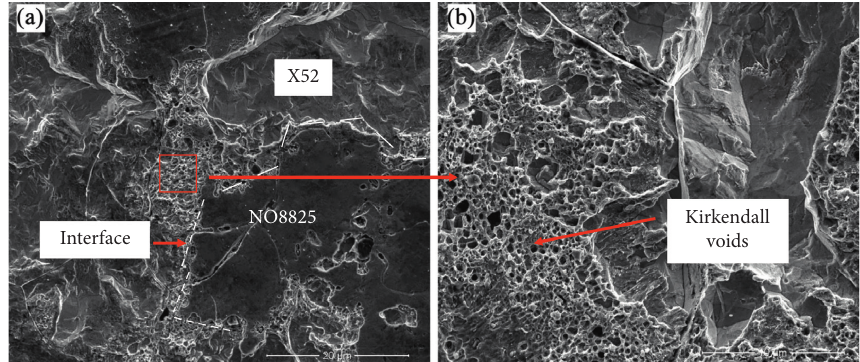
Figure 4: Morphologies of the fresh revealed peeling surface on the carbon steel side: (a) the fresh revealed peeling surface with less nickel- based alloy and (b) enlarged view of the red line marked area in Figure